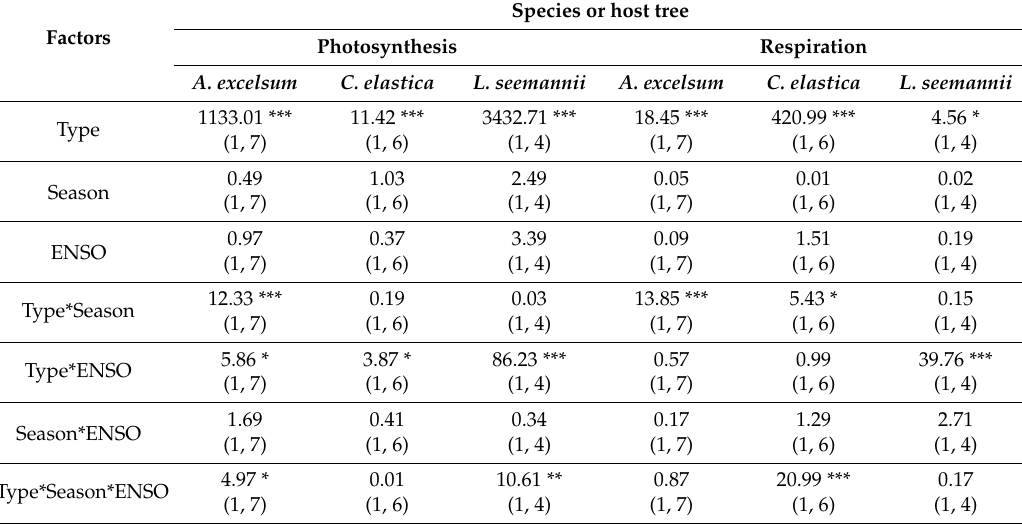
Table 3. Effect of the leaf type (tree or liana leaf), season, ENSO, and their interaction on the normalized difference of photosynthesis and leaf respiration of the values predicted. Values represent F-ratios , values in parentheses describe the degree of freedoms, and the asterisks represent the